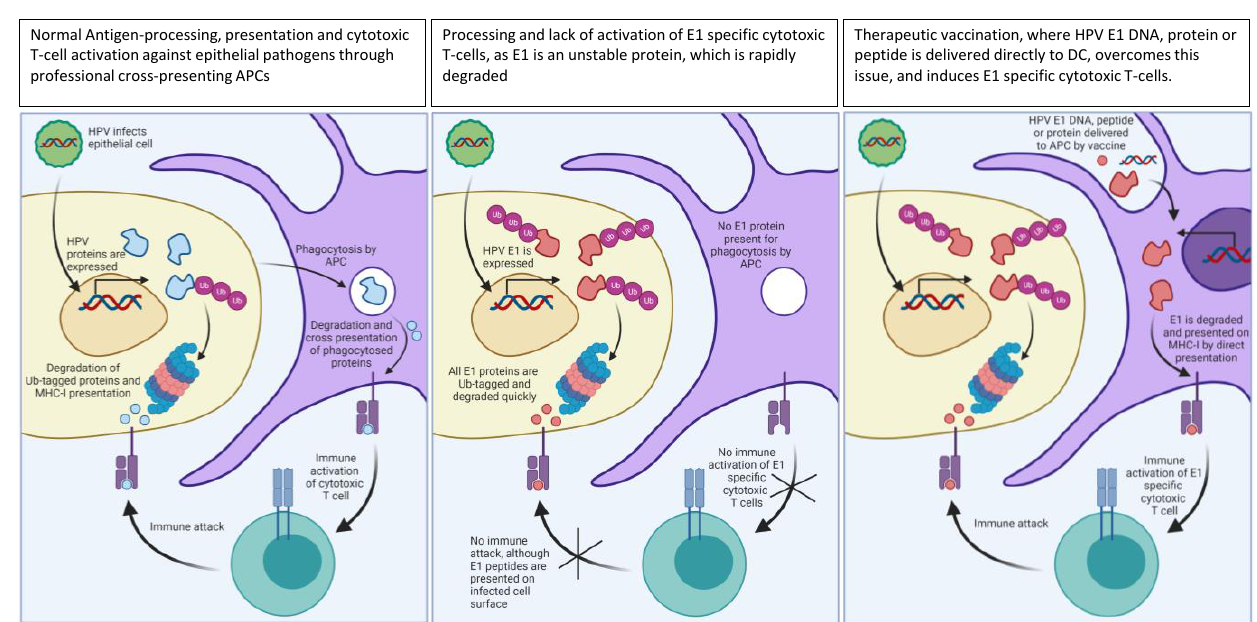
Figure 1. Normal processing and immune activation of viral or tumor antigens ( left panel), of an unstable protein such as E1 ( middle panel) and how therapeutic vaccines against such unstable proteins can induce beneficial cytotoxic immune responses ( right panel). Figure created with Biorender.com, accessed on 1 November 2021.